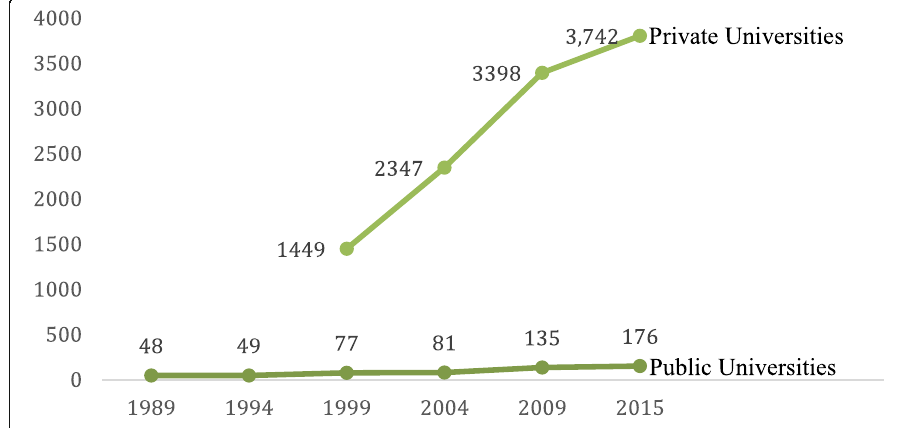
Fig. 1 Number of public and private universities (BPS, 2017. Data is combined between Ministry of Research, Technology, and Higher Education (MRTHE) and Ministry of Religious Affairs (MORA). Data from 1989 to 2004 only from